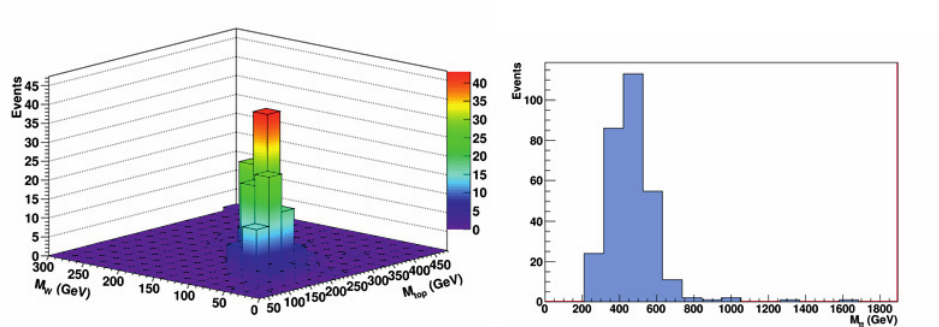
Figure 6. Reconstructed m t and m W per event for a sample of 300 Z (cid:3) → t¯t generated with m Z (cid:3) = 500 GeV (left) as well as reconstructed m Z (cid:3) for the same events (right).